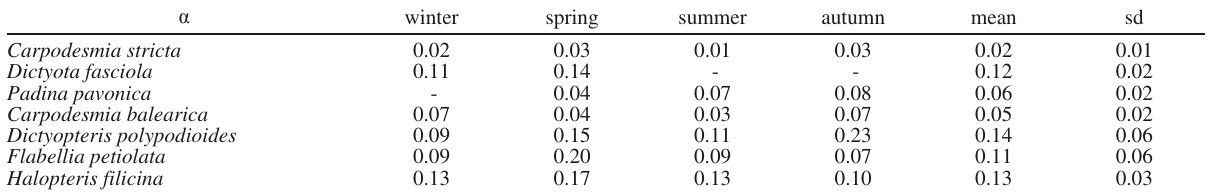
Table 6. – Photosynthetic efficiency ( α ) for species and season.